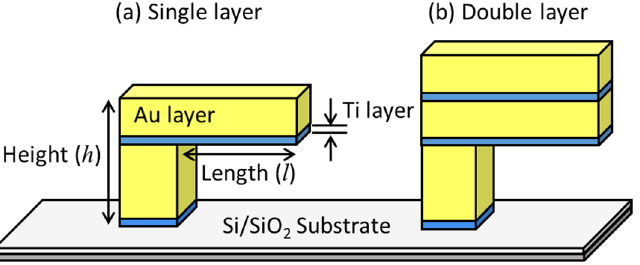
Figure 1. Schematics of the Ti/Au ( a ) single and ( b ) double layered micro-cantilevers. Three types of the fixed-end condition of the micro-cantilever were studied as shown